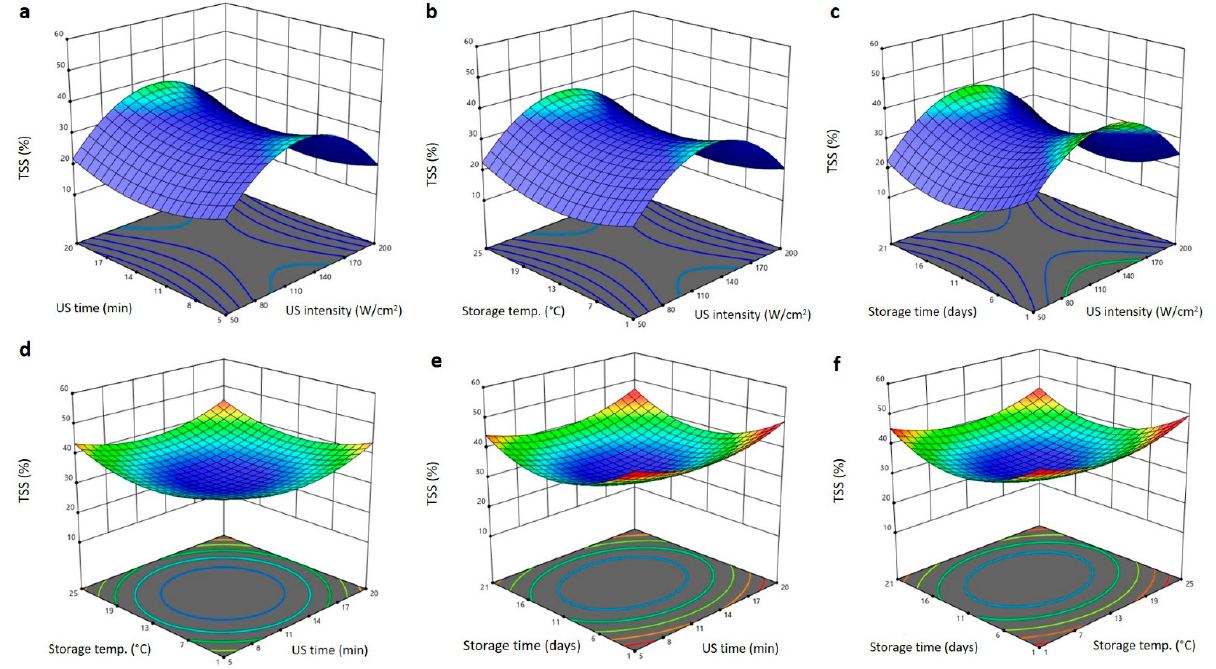
Figure 2. Response surface plots of total soluble solids (TSS) of Barhi dates as a function of US time and US intensity ( a ), storage temperature and US intensity ( b ), storage time and US intensity ( c ), storage temperature and US time ( d ), storage time and US time ( e ), and storage time and storage temperature ( f ).